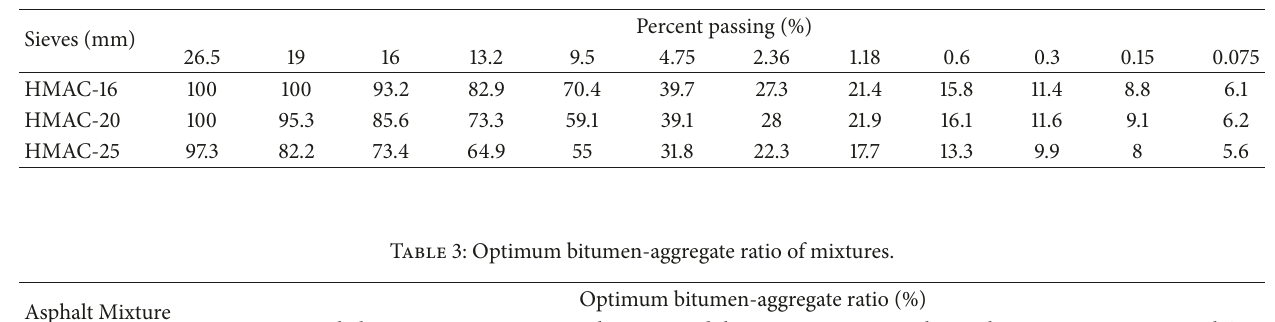
Table 2: Aggregate gradations of HMAC.